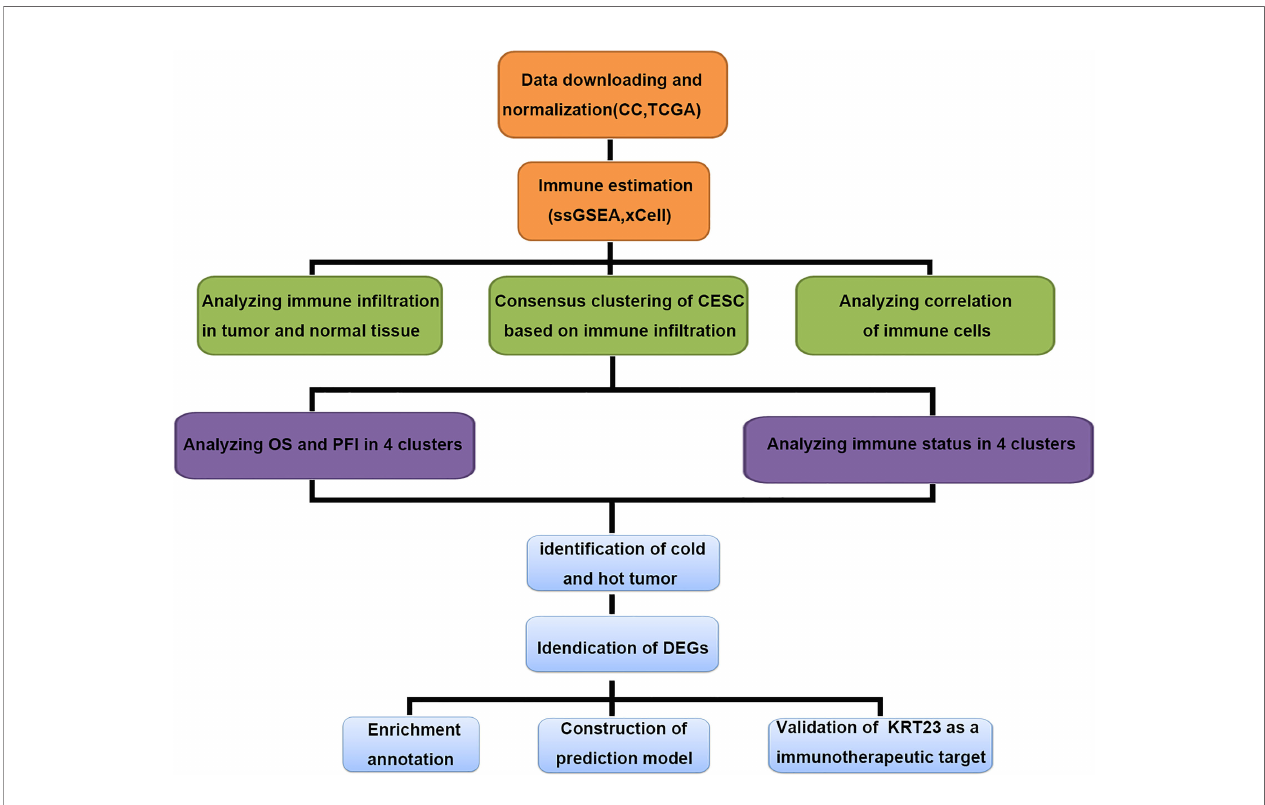
FIGURE 1 | Multiple-step analysis of this